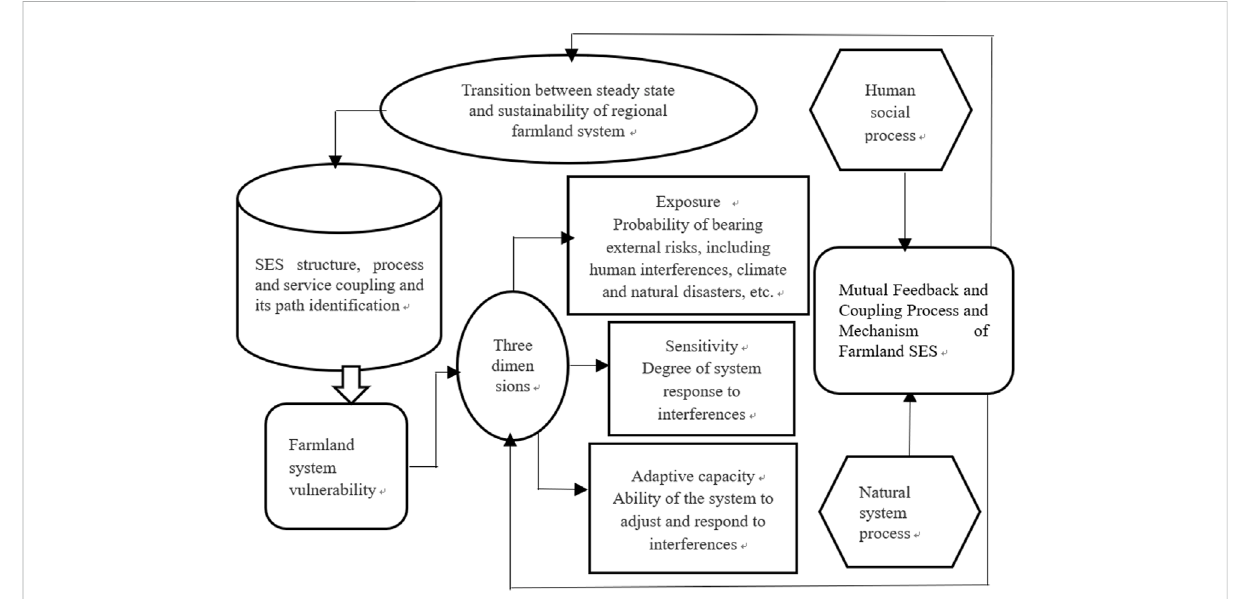
FIGURE 1 Vulnerability elements and interrelations of the farmland